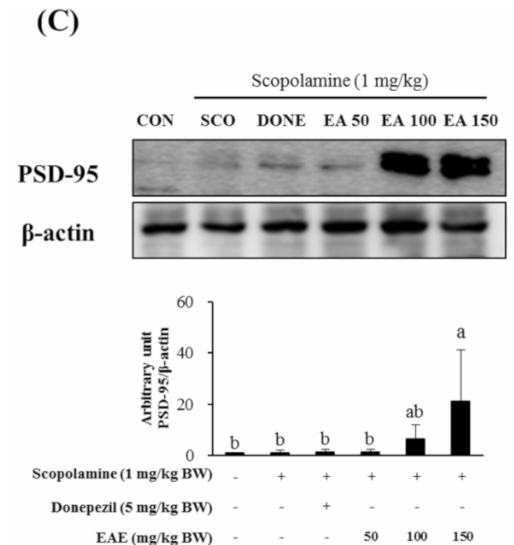
Figure 6. E ff ects of EAE on the protein levels of nuclear Nrf2 ( A ) and protein expression of HO-1 ( B ) and PSD-95 ( C ) in the mouse hippocampus. Results are expressed as mean ± SD ( n = 3). Statistical analysis was performed using one-way ANOVA, following Duncan’s multiple range test. Bars not sharing common alphabetical letters (a,b) represent significant di ff erences from each other ( p < 0.05). 3.7. E ff ects of the Oral Administration of EAE on the Scopolamine-Induced Neuronal Damage in